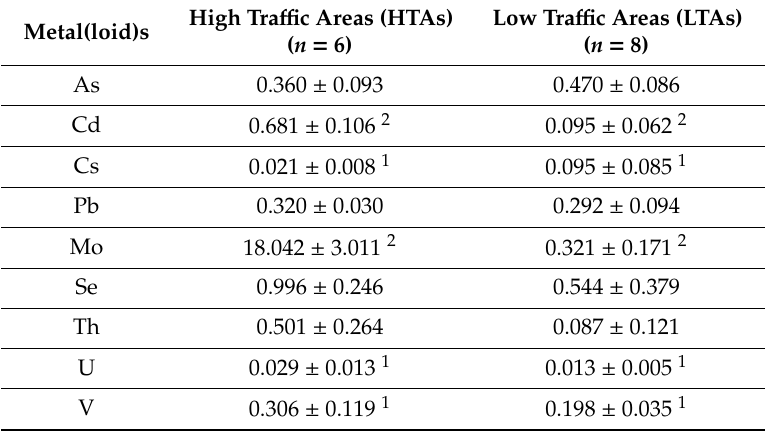
Table 2. Metal(loid) concentrations in aboveground portions of T. megapotamicum from HTAs and LTAs. Data expressed as mean ± SD, reported in mg /